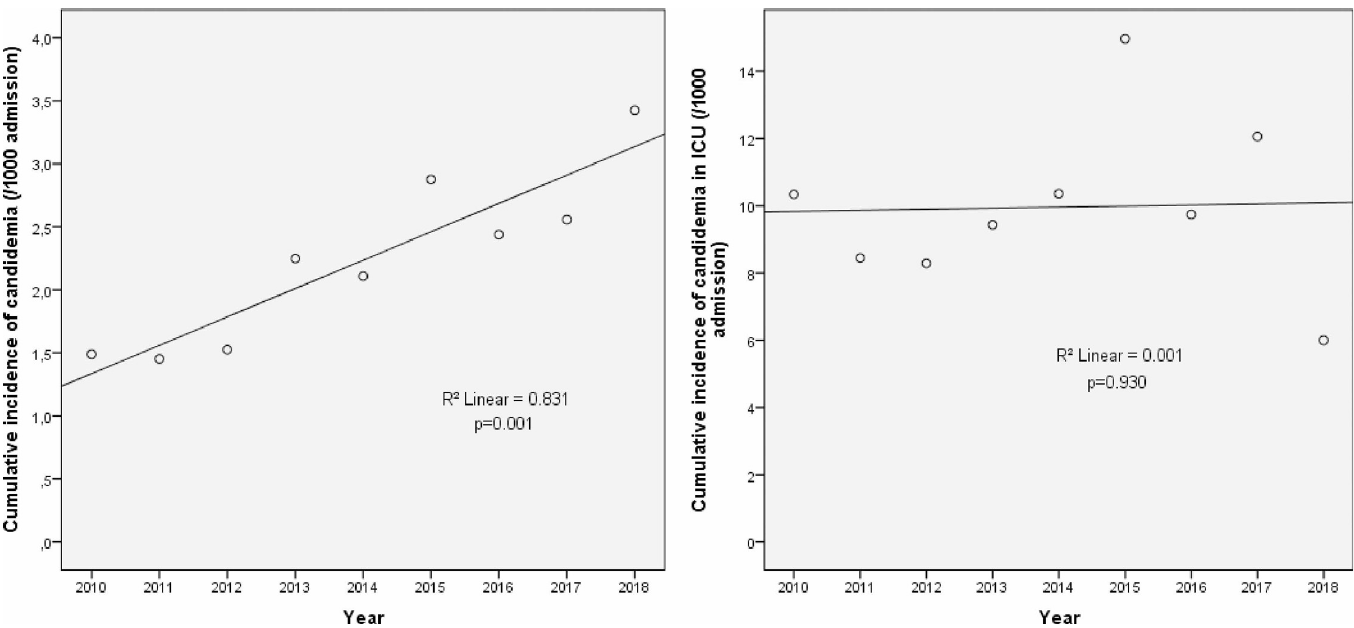
Fig 1. Cumulative incidence of candidemia over nine years in the overall population (A) and in ICU patients (B).